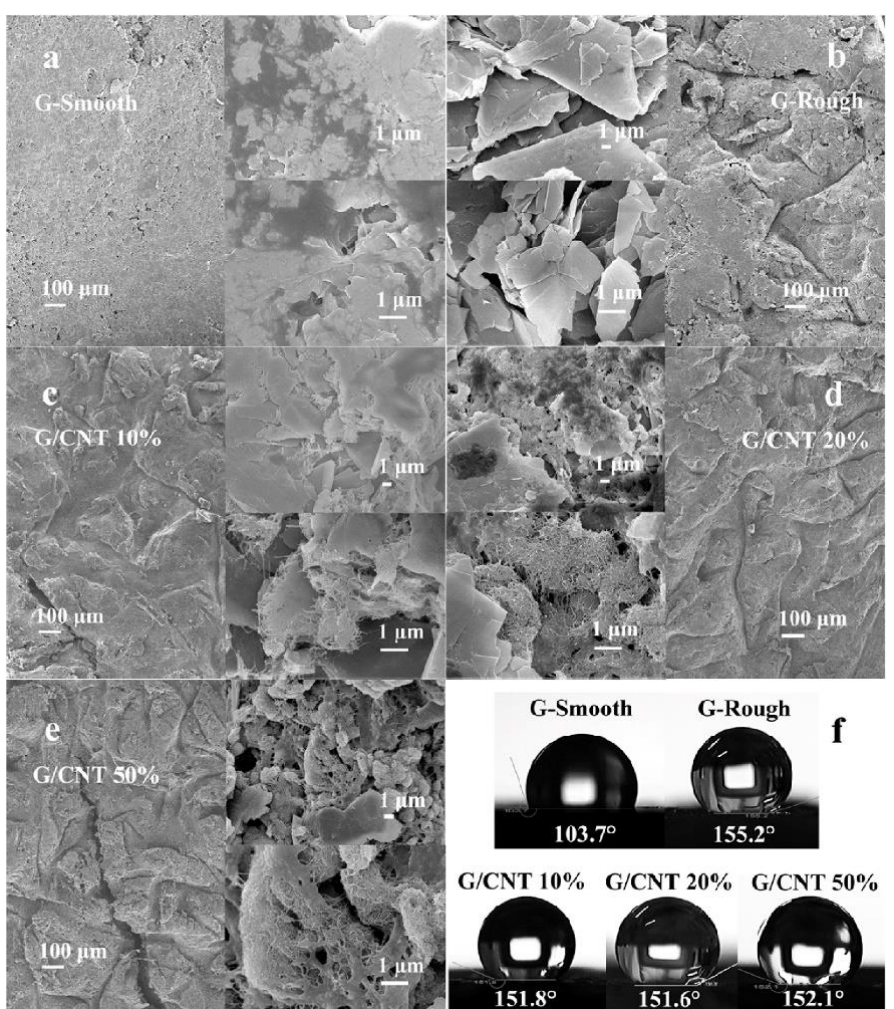
Figure 6. SEM images of “G-Smooth” cathode ( a ), “G-Rough” cathode ( b ), “G/CNT 10%” cathode ( c ), “G/CNT 20%” cathode ( d ), and “G/CNT 50%” cathode ( e ); Water contact angle images of the cathodes ( f )